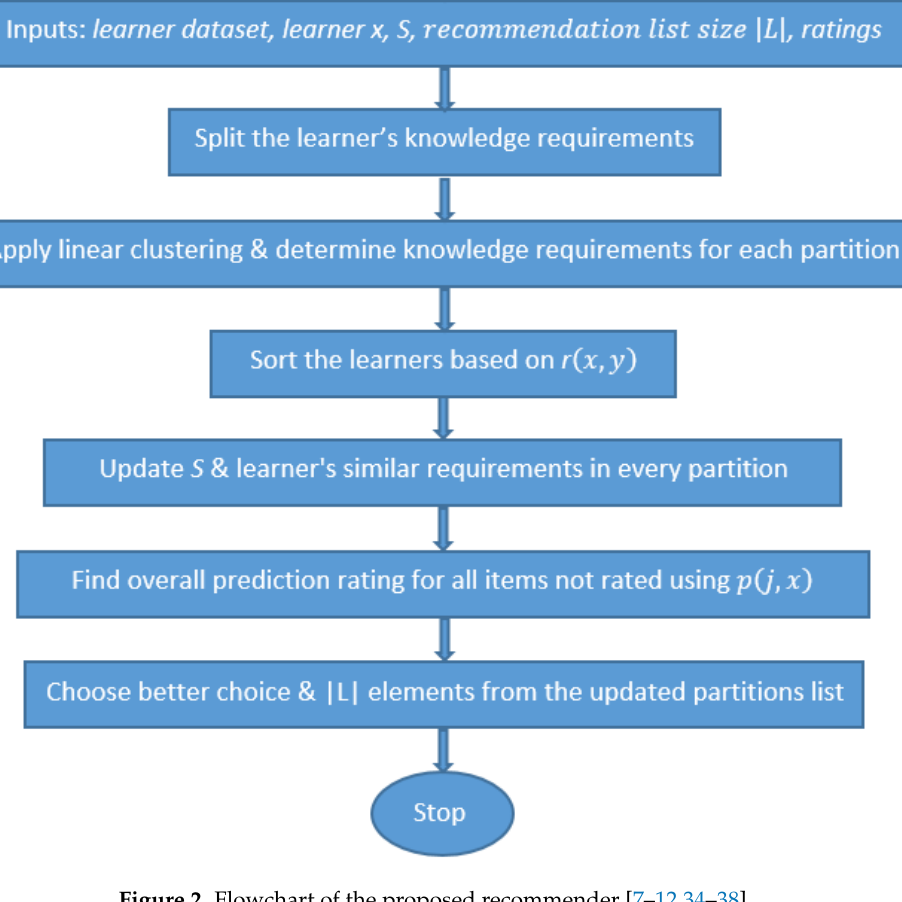
Figure 2. Flowchart of the proposed recommender [7–12,34–38]. Algorithm 2: New clustered intelligent CF